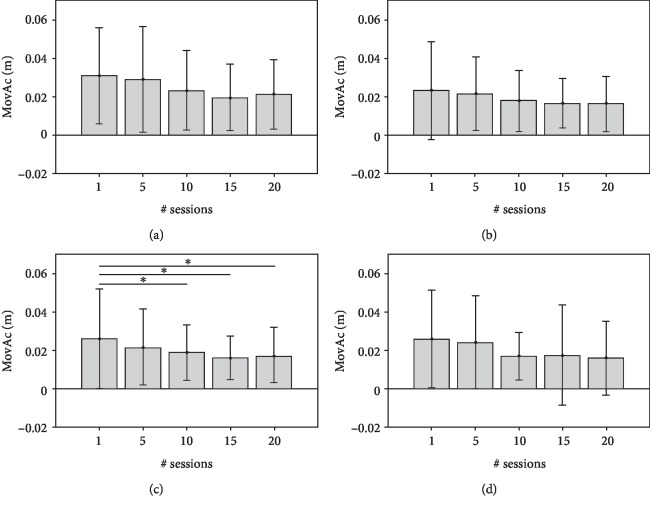
MovAc values (mean and standard deviation) at 1st, 5th, 10th, 15th, and 20th sessions of RT and significant post hoc comparisons between sessions (Conover's test): ∗p value < 0.05; ∗∗p value < 0.001; ∗∗∗p value < 0.0001. The data obtained by analysing the end-effector trajectories towards the four targets (A, B, C, D) are showed separately.